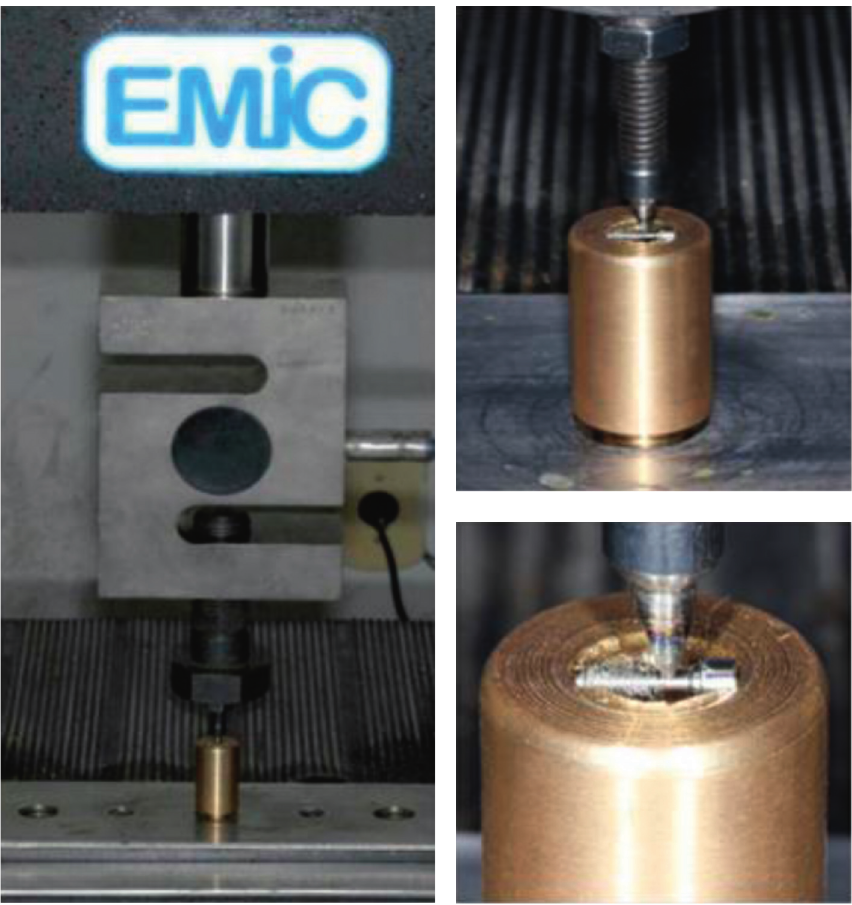
Figure 5: View of the screw positioned in the EMIC with a close-up view of the fracture resistance of the retaining